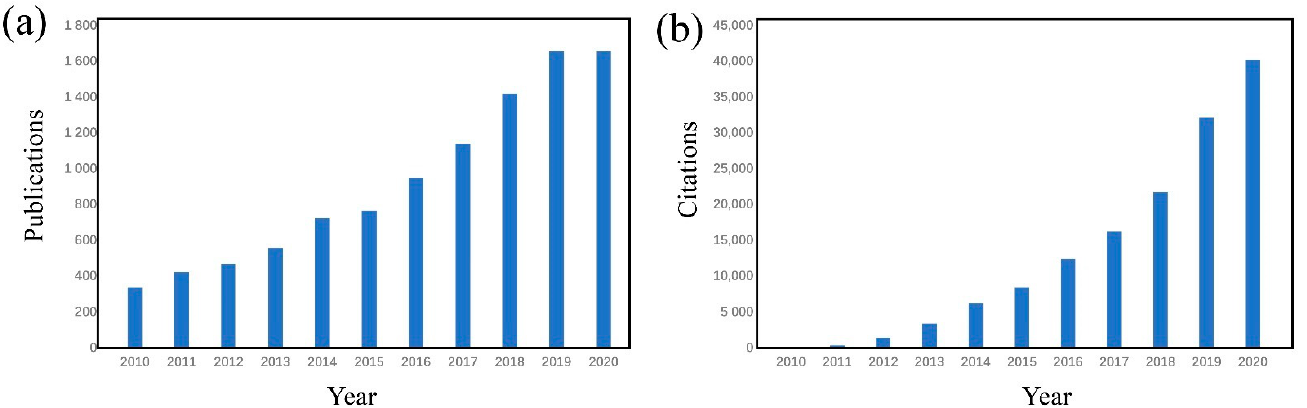
Figure 2. The statistics data of the publications on the topic electrospinning membranes from Web of Science. ( a ) Publications and ( b ) citations in each year. Data were collected in the past 10 years (2010–2020).